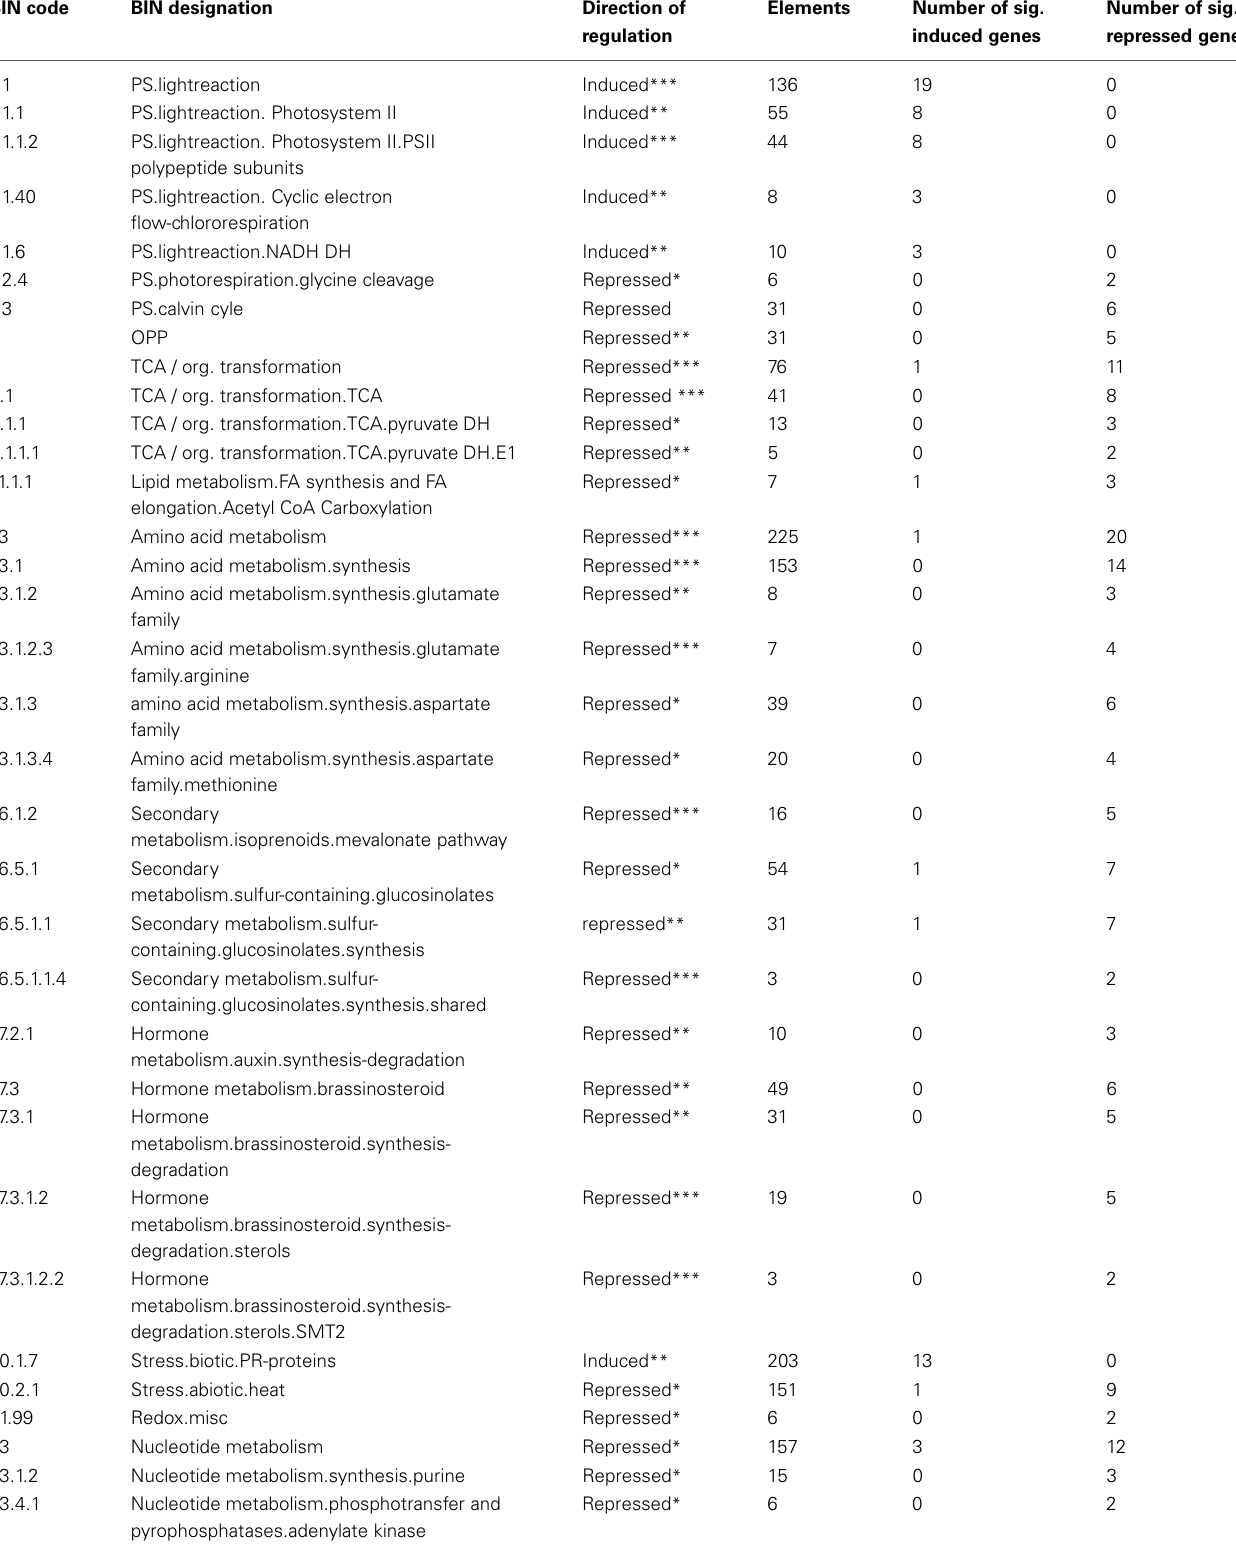
Table 2 | Significantly regulated functional categories. BIN